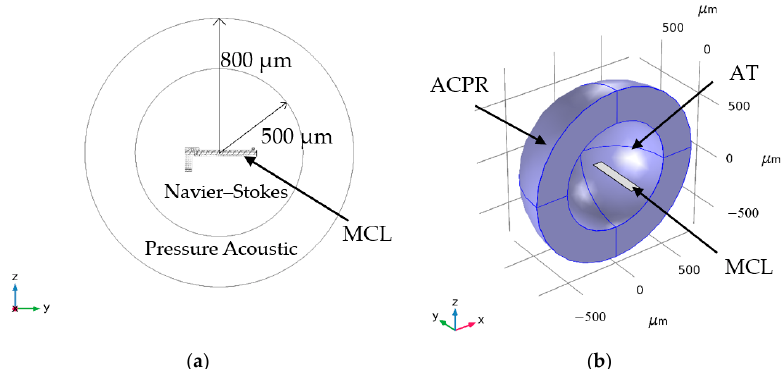
Figure 5. Geometry of air around the MCLs. ( a ) A cross-sectional schematic of the 3D finite element model; ( b ) A 3D cut image of the finite element model. model; ( b ) A 3D cut image of the finite element